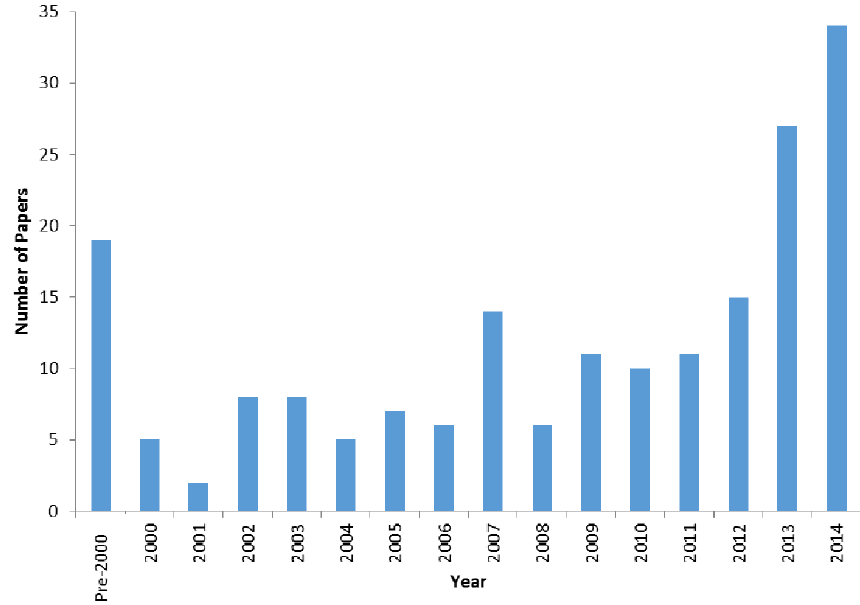
Figure 1. Distribution of years in which papers included in this review were